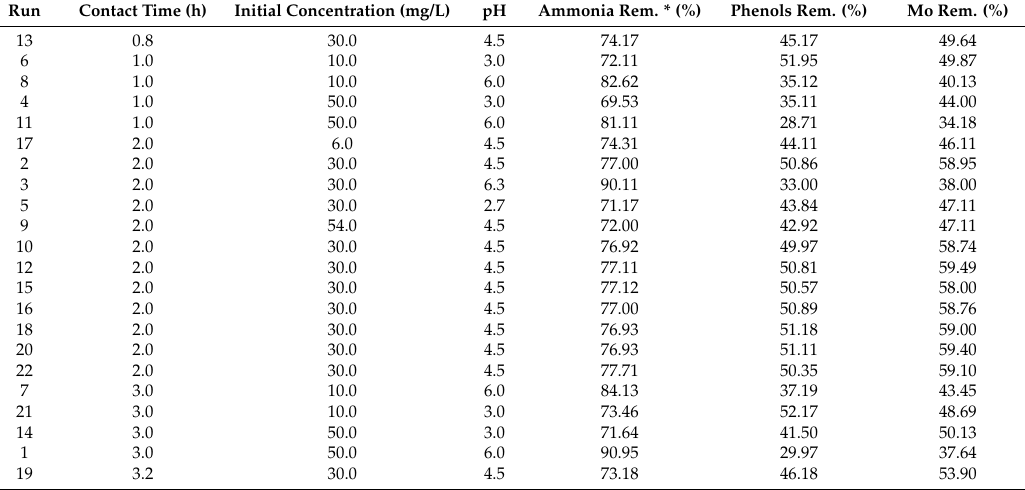
Table 3. Response values under different experimental conditions.